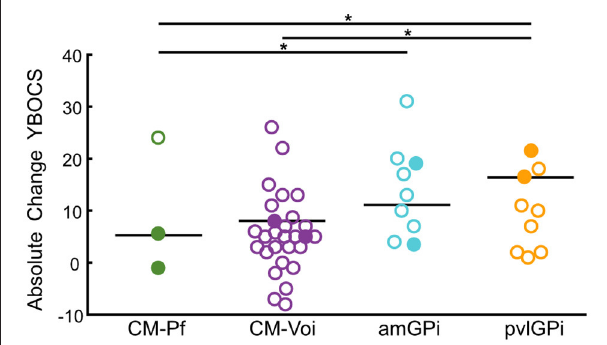
FIGURE 5 | Scatterplots of YBOCS absolute change scores for the different targets at maximum follow-up. Circles represent individual studies; color-filled circles represent more heavily weighted studies (more participants). Horizontal bars show the median values for each target. Significant differences between targets are indicated with asterisks ( p <